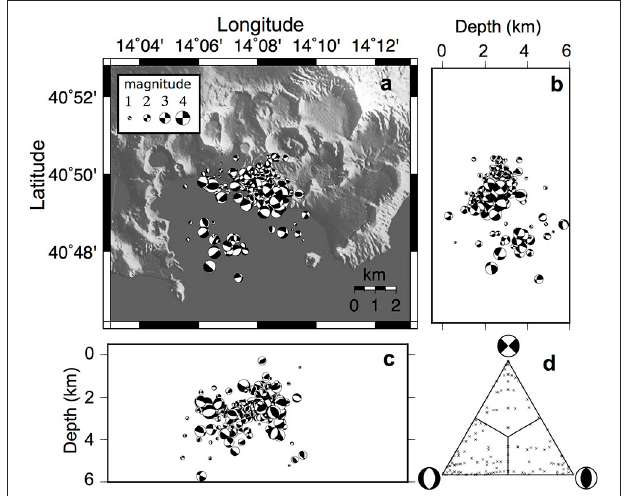
FIGURE 7 | Campi Flegrei. Focal mechanisms dataset plotted on a shaded map (A) , on a N-S (B) , and an E-W (C) cross sections. (D) The distribution of focal mechanisms on a triangular Frohlich diagram ( Frohlich, 1992). The dataset consists of 217 events with 0 < M < 4 occurred between 1983 and 1984.